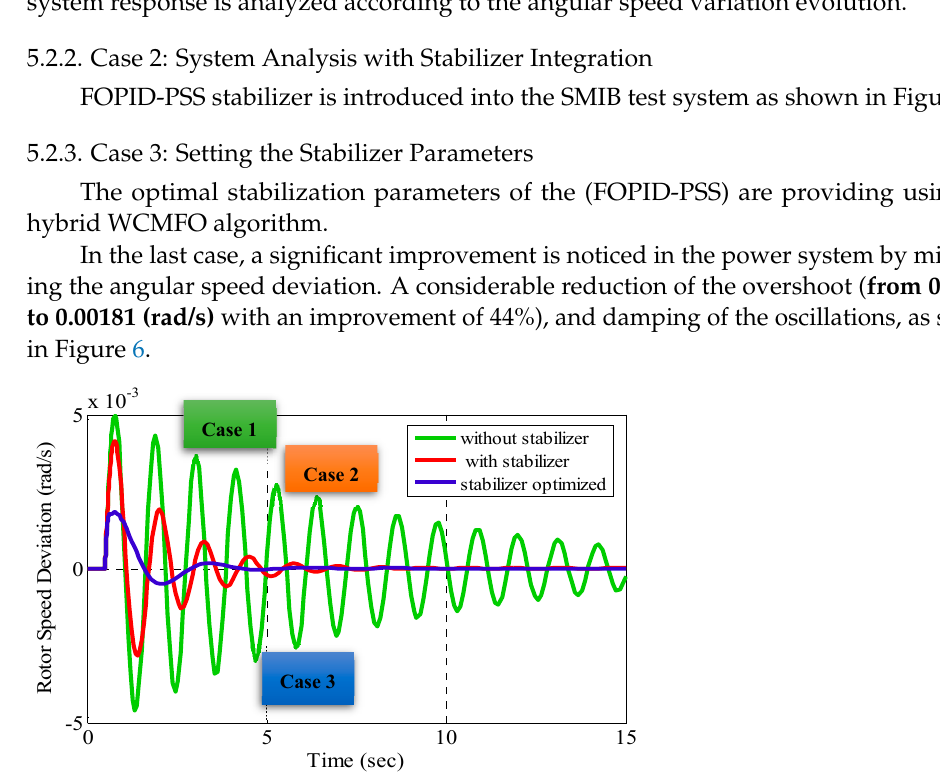
Figure 6. Angular speed deviation (with and without stabilizer).